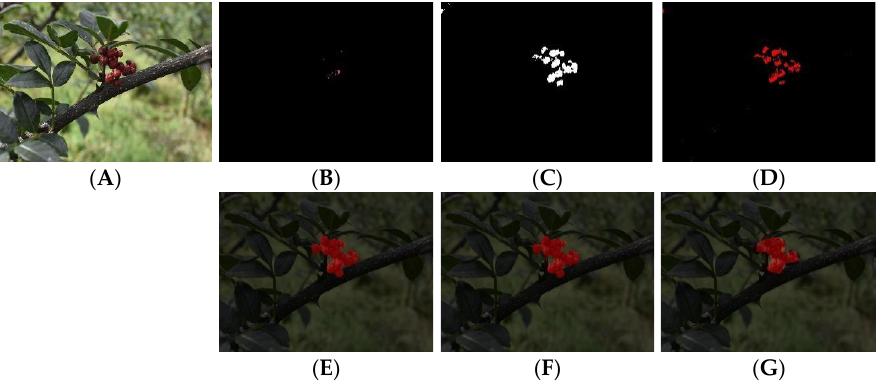
Figure 11. ( A ) Single backlit cluster without occlusion; ( B ) results from RGB algorithm for segmen- tation; ( C ) results from HSV algorithm for segmentation; ( D ) results from k-means algorithm for segmentation; ( E ) results from U-Net algorithm for segmentation; ( F ) results from DeepLabV3+ al- gorithm for segmentation; ( G ) results from PSPnet algorithm for segmentation